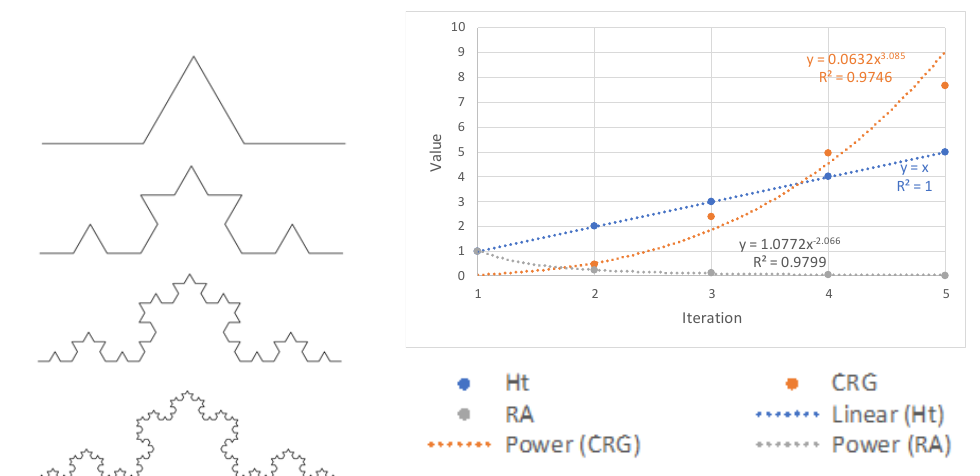
Figure 4. (Color online) Using the first five iterations of the Koch curve to illustrate CRG and RA supplementing the ht-index in terms of capturing sensitivity.